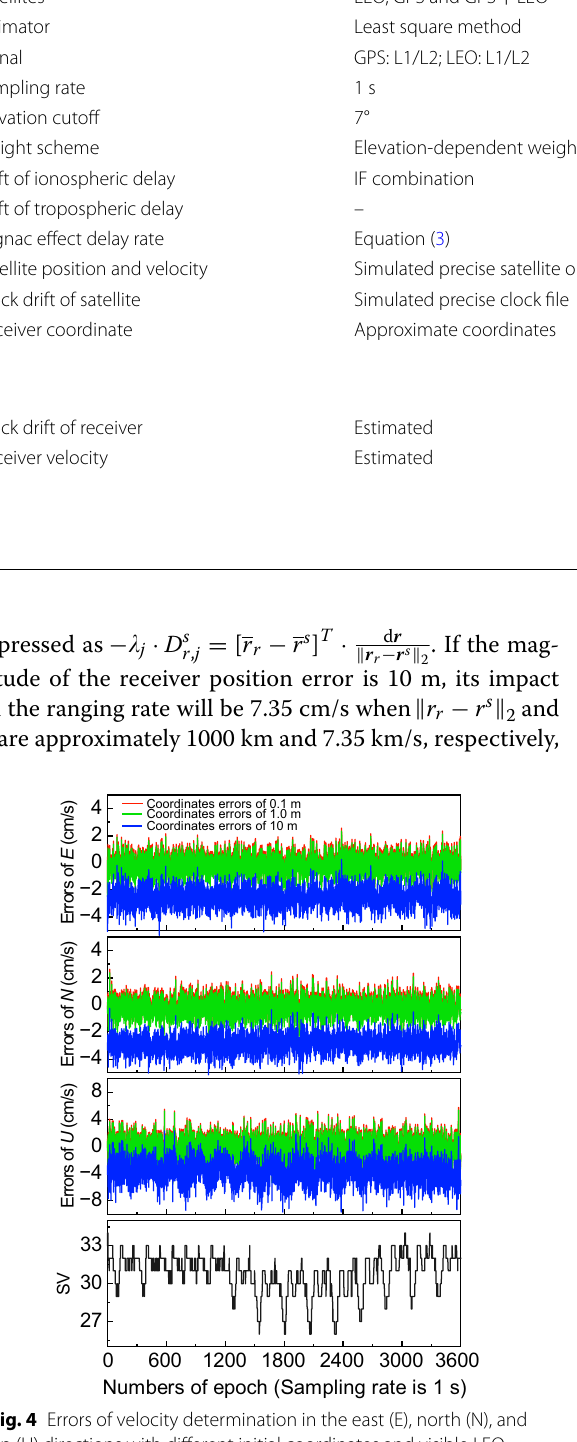
Fig. 5 RMSE of LEO velocity determination in the east, north, and up directions with different initial errors of coordinates at station